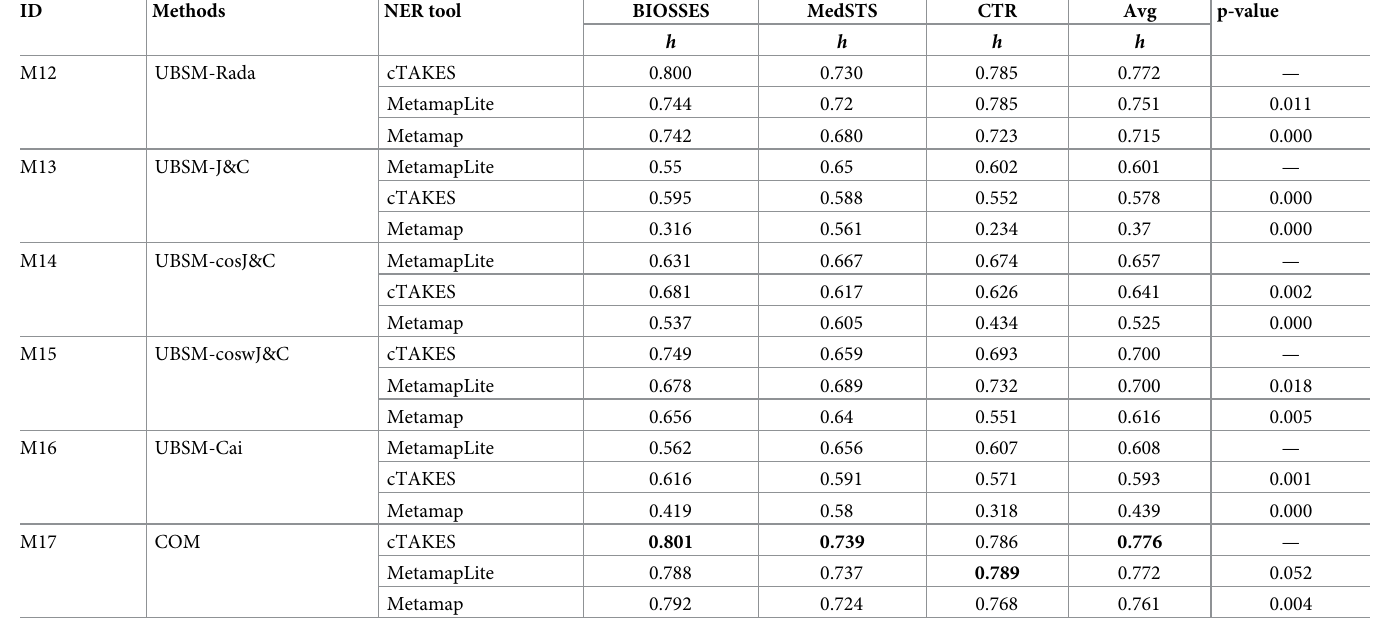
Table 11. Harmonic score obtained by each combination of a sentence similarity method with a NER tool in the evaluation of the three sentence similarity datasets. The p-values shown in this table are obtained by using the method for building uniform size datasets detailed above. The last column shows the p-values corresponding to the t-Student test comparing the performance of each combination with the best pair in each group.